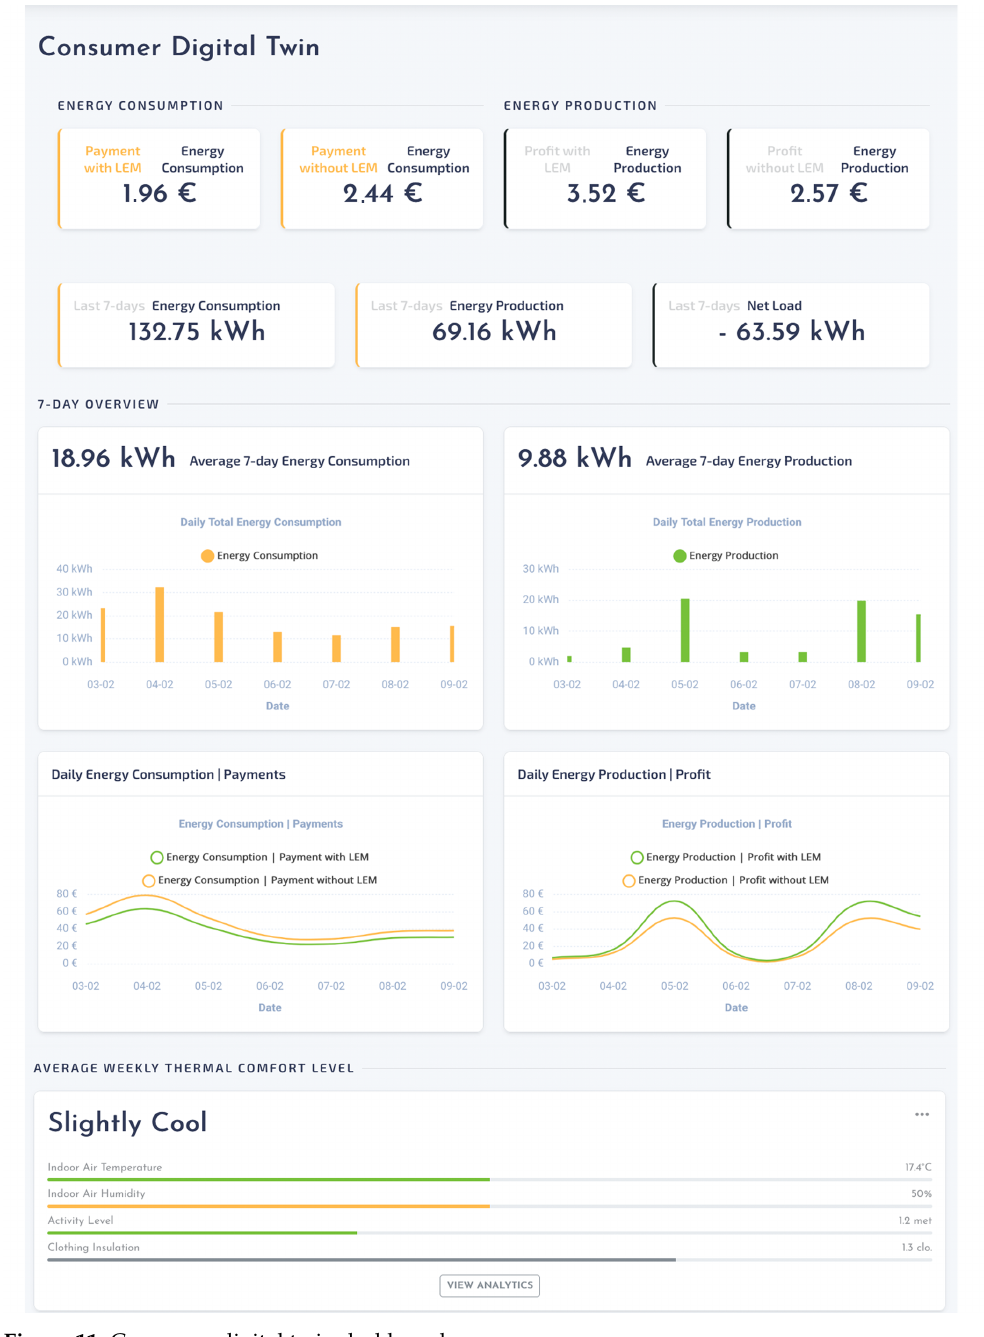
Figure 11. Consumer digital twin